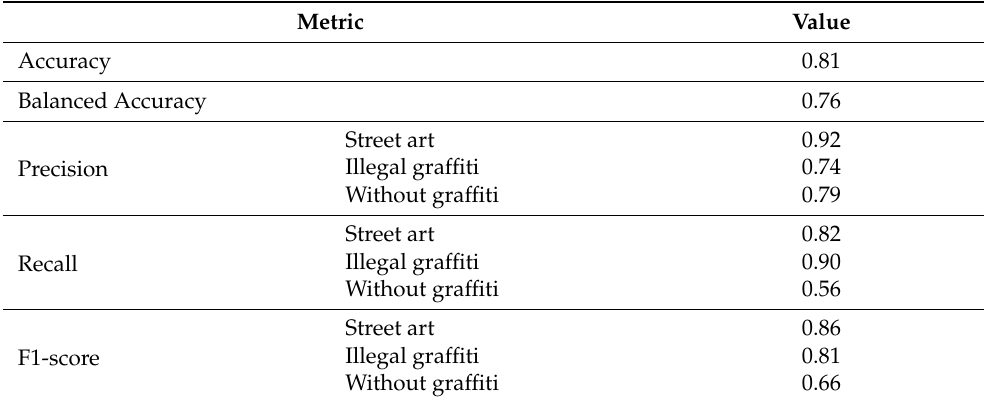
Table 8. Classification metrics for the test